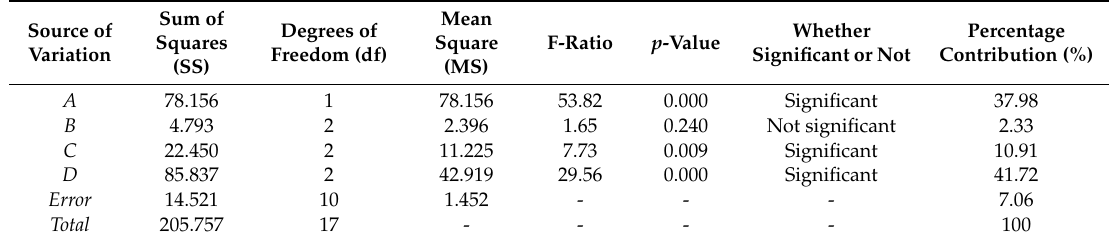
Table 12. Analysis of variance (ANOVA) results for S/N ratios.